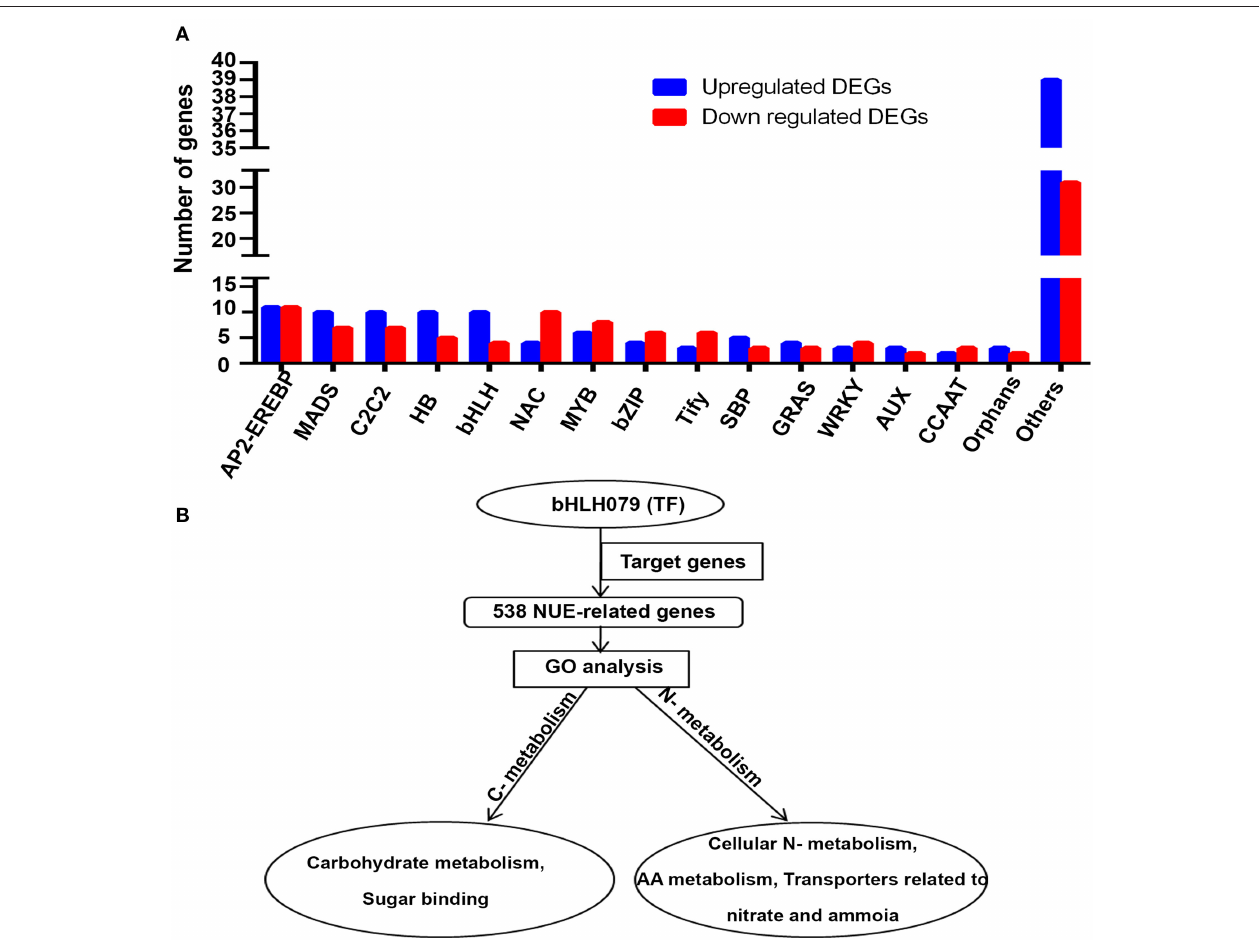
FIGURE 4 | (A) Upregulated and downregulated NUE-related transcription factors (TFs). (B) Role of TF OsbHLH079 and its target genes in regulating carbon–nitrogen metabolism. AP2-EREBP, a ptela-2/ethylene-responsive element binding protein; MADS, Minichromosome maintenance1, agamous deficiens and serum response factor; C2C2, CO-like, Con stans-like zinc finger family; HB, Homeobox TF family; bHLH, Basic helix-loop-helix family; NAC, NAM, ATAF, and CUC; MYB, myeloblastosis; bZIP, Basic leucine zipper; SBP, Squamosa promoter binding protein-like; GRAS, Gibberellic-acid insensitive (GAI), repressor of GAI (RGA), and scarecrow (SCR); WRKY, AUX, Auxin/indole-3-acetic acid; CCAT, calcium channel associated transcriptional